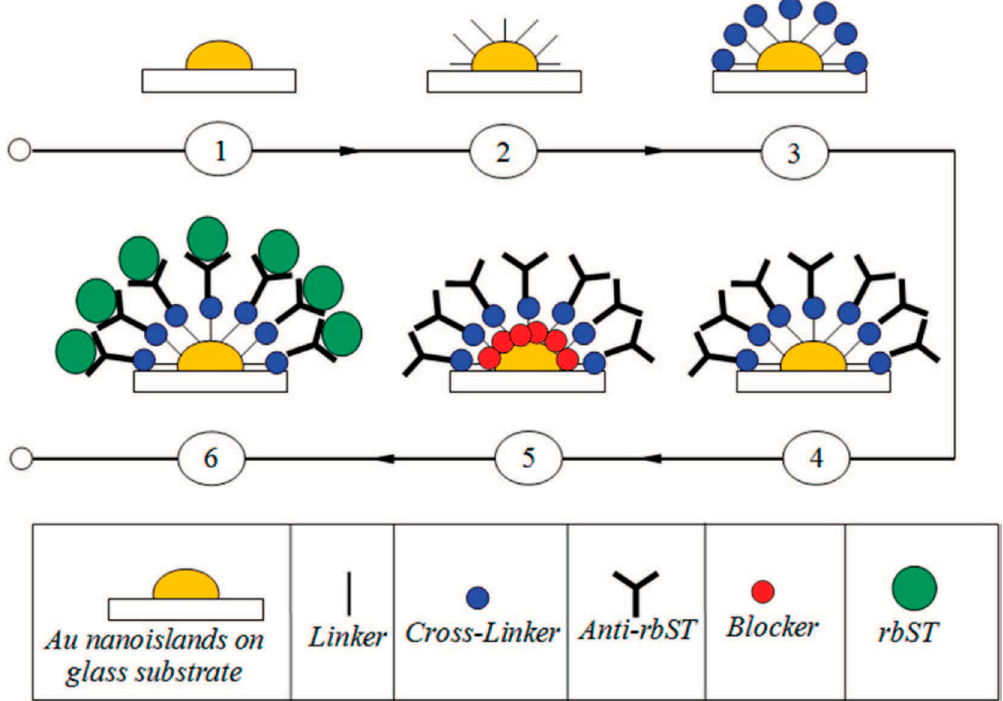
Figure 9. Immunoassay protocol for the detection of recombinant bST (rbST). (1) Sample with gold nano-islands, (2) gold nano-islands with linker, (3) sample after adding cross-linker, (4) sample after adding anti-bST, (5) sample after adding a blocker, and (6) sample after adding rbST (reproduced with permission from [44], copyright 2015, American Dairy Science